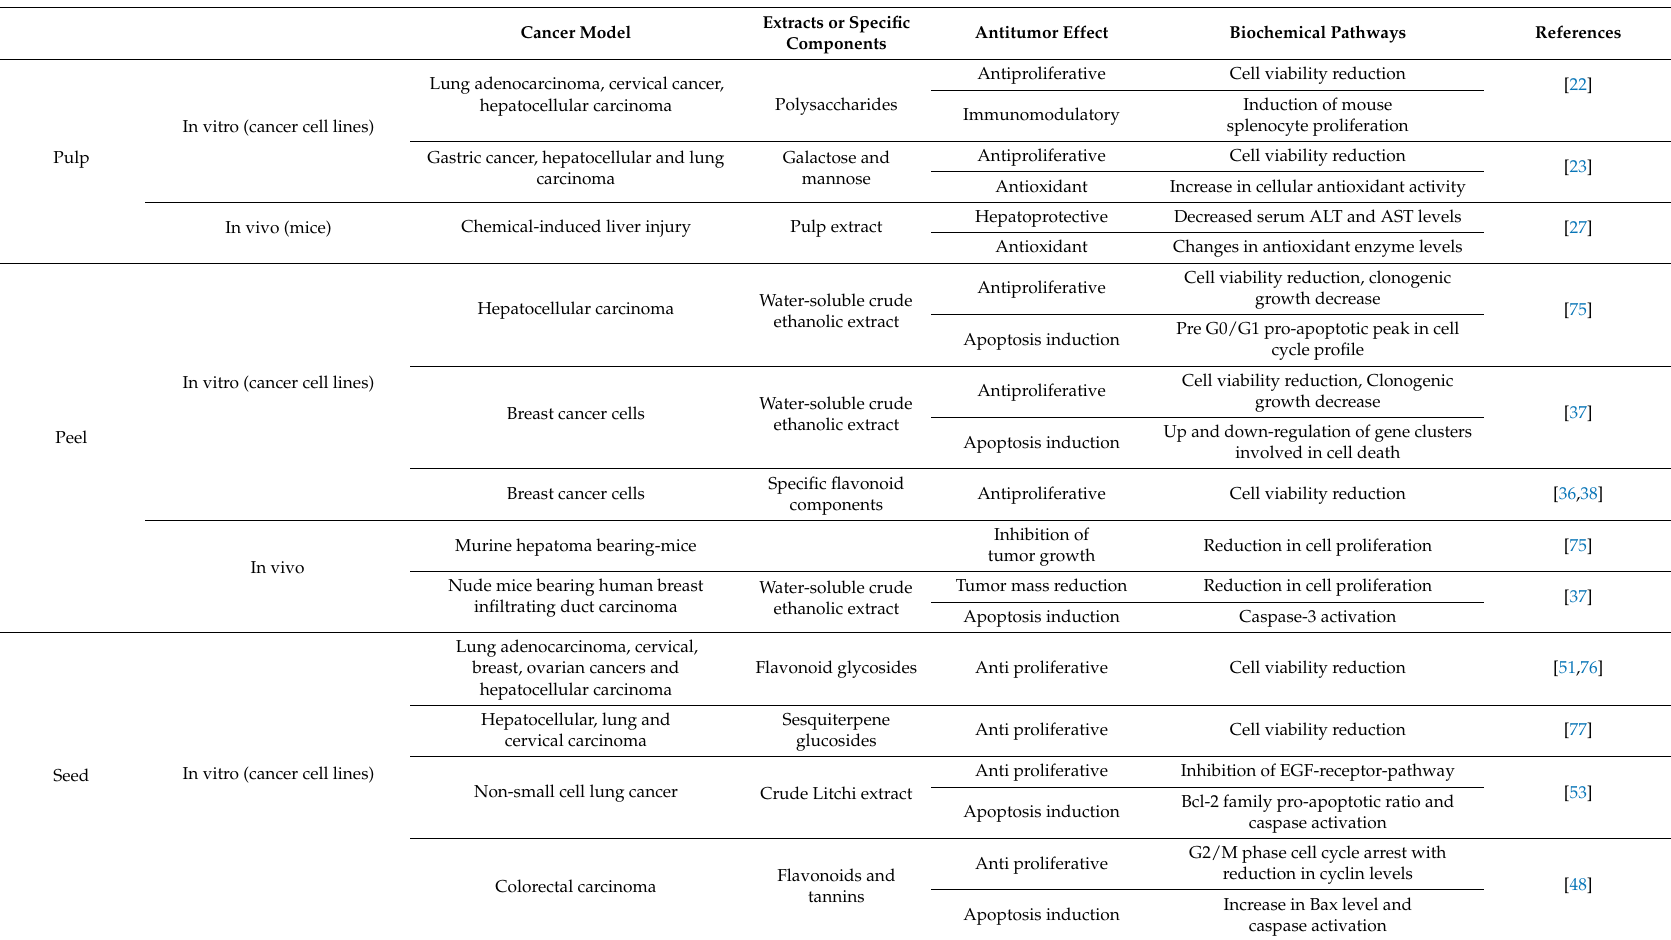
Table 2. Specific antitumor effects of Litchi fruit portions and principal involved biochemical